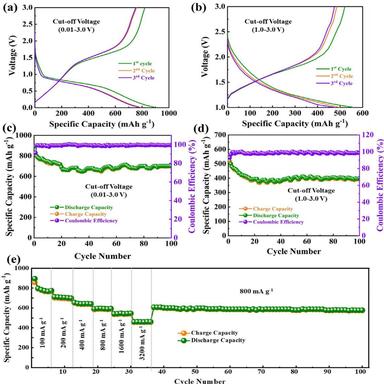
Fig. 5. Electrochemical properties of the as-prepared flower-like FS nanostructure as an anode material for LIBs. GCD profiles of the FS-based LIBs operated at different charge-discharge potentials of (a) 0.01–3.0 V and (b) 1.0–3.0 V, respectively. Cyclic performance of the FS-based LIBs obtained at different potentials of (c) 0.01–3.0 V and (d) 1.0–3.0 V, respectively. (e) Rate capability performance of the corresponding material at different current densities of 100-3200 mA g−1 with the working potential